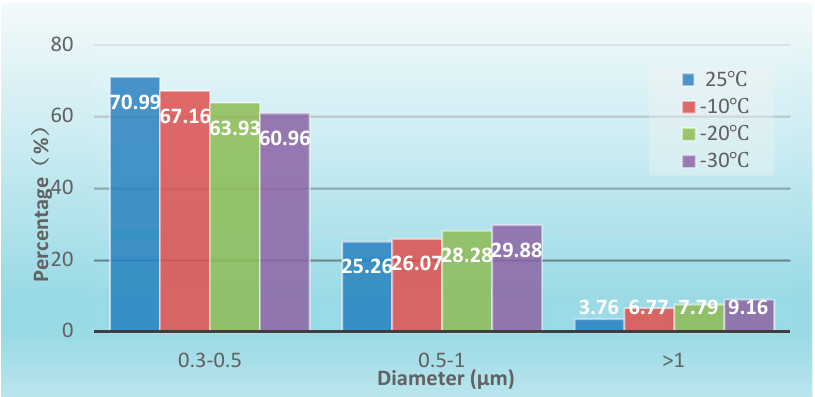
Figure 12. Distribution of the pore diameter under various temperatures.